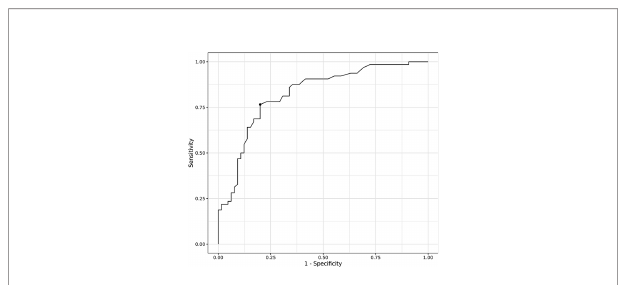
FIGURE 2 | Receiver Operation Characteristic (ROC) curve for